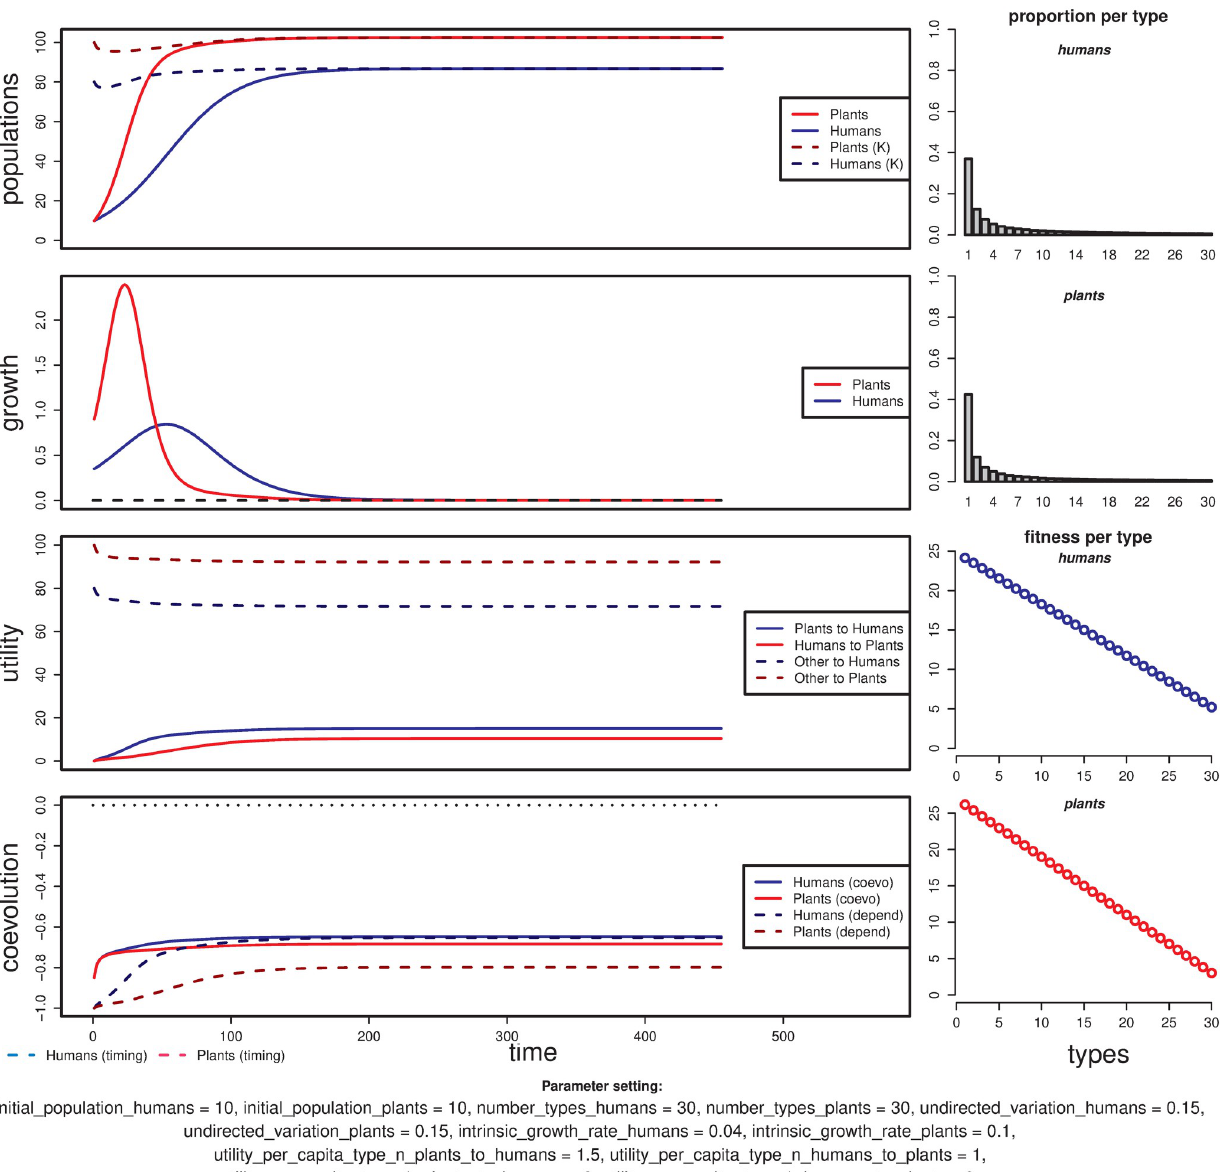
Fig 4. Example of a simulation run producing a trajectory without coevolution. The dynamics is reduced to the changes required for the initial populations to adjust their levels and type distribution to the least mutualistic stable state under the given